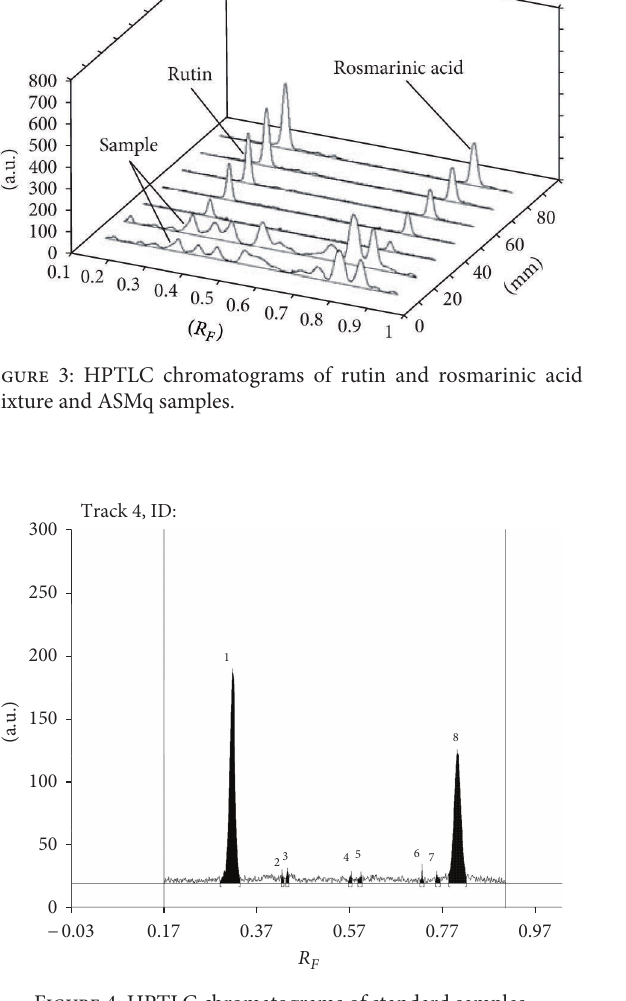
F 4: HPTLC chromatograms of standard samples.